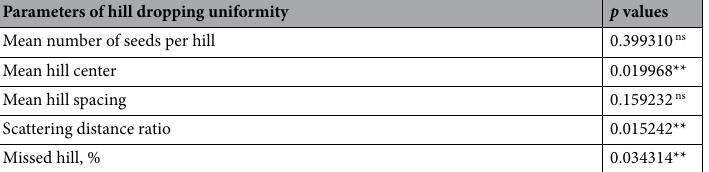
Operating speed (cm s −1